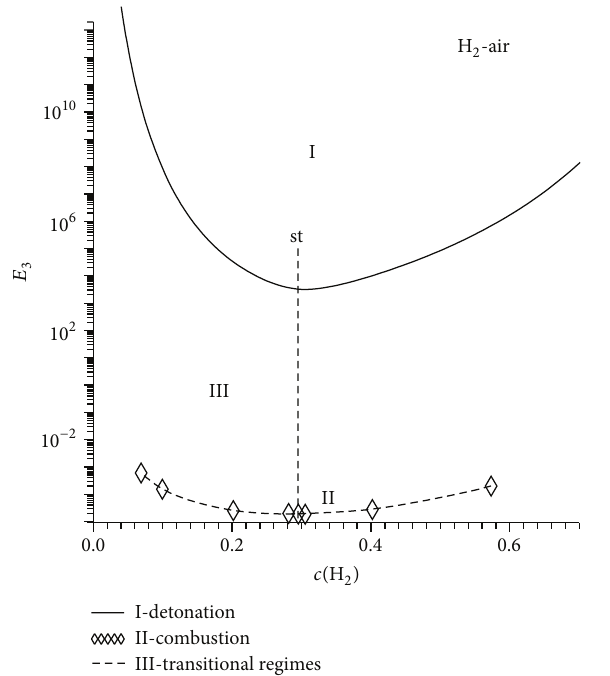
Figure 14: Critical initiation energy ( 𝑦 -axis) on duration of dis- charge ( 𝑥 -axis), both normalized on values for ideal